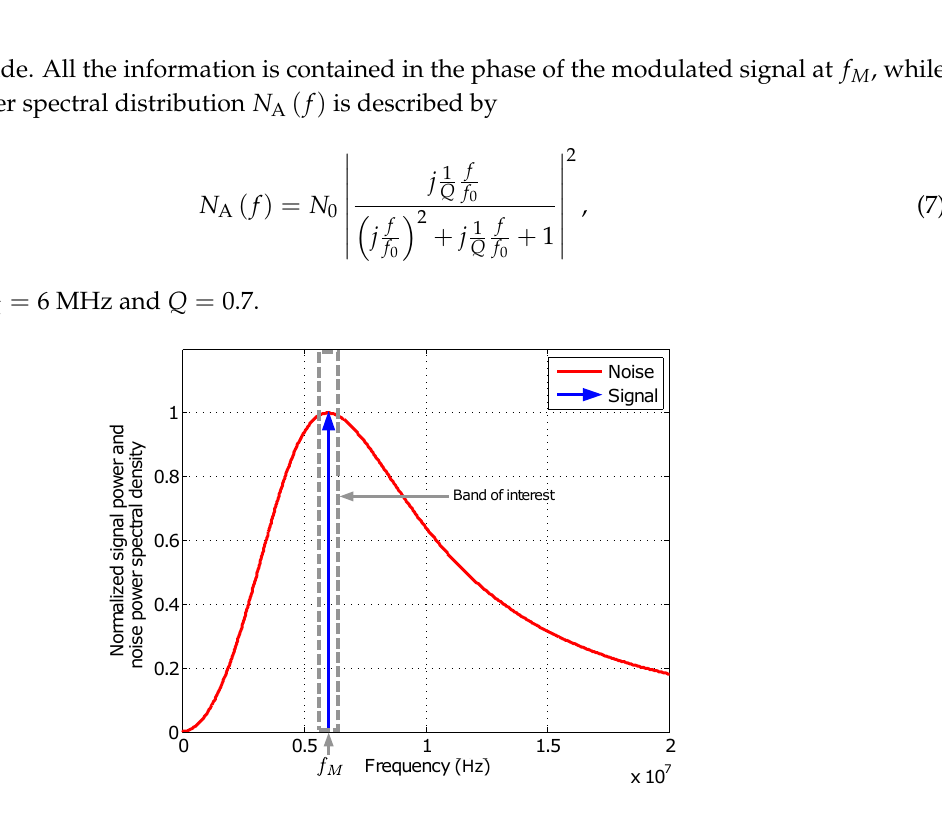
Figure 2. Normalized single-sided power spectral density of noise and signal power before sampling. The signal-to-noise ratio, calculated for a reference bandwidth of 1 Hz, is defined for this analog signal